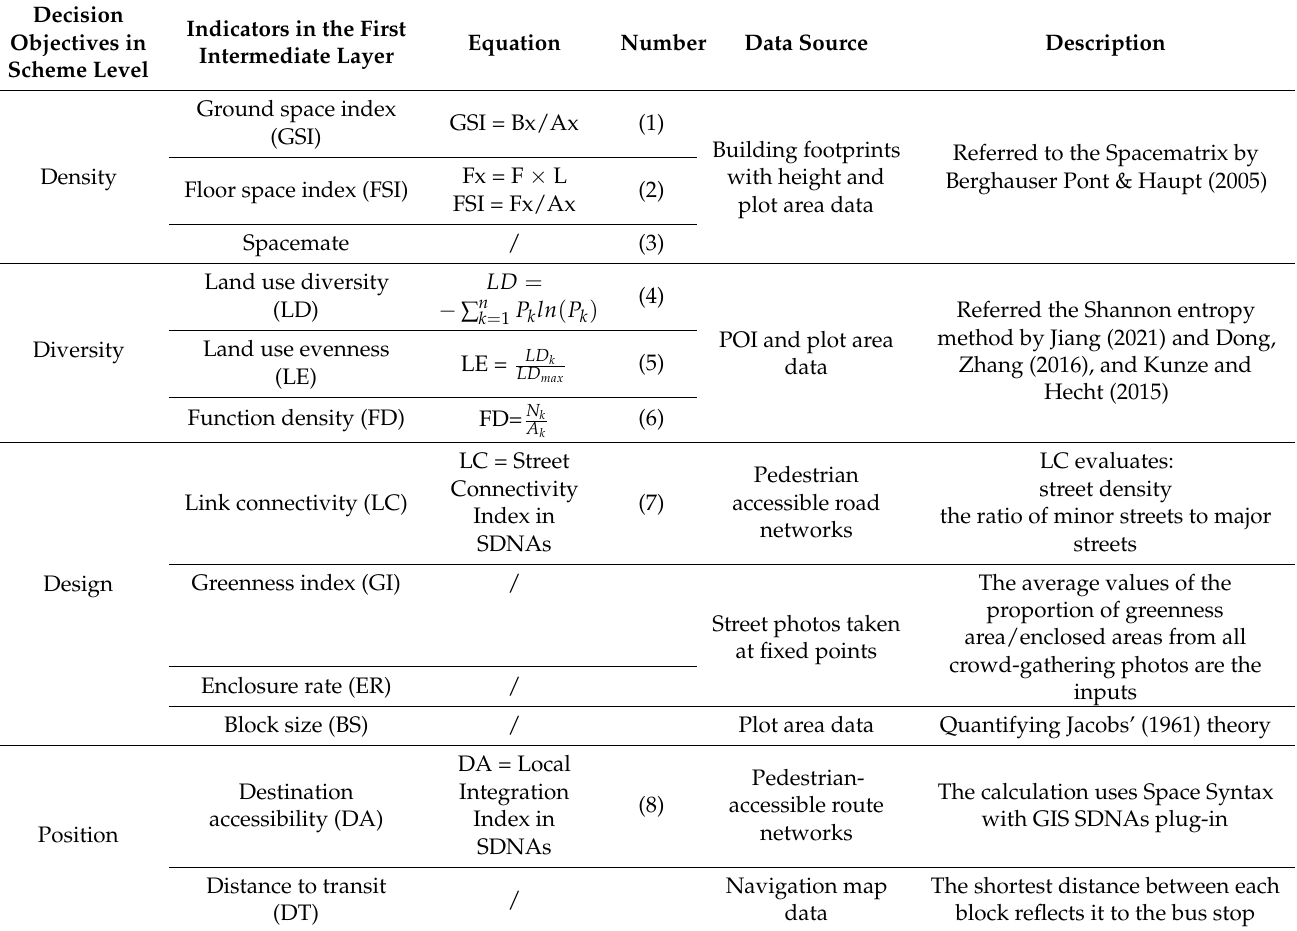
Table 2. Quantification calculation method for community vitality impact factors designed in our